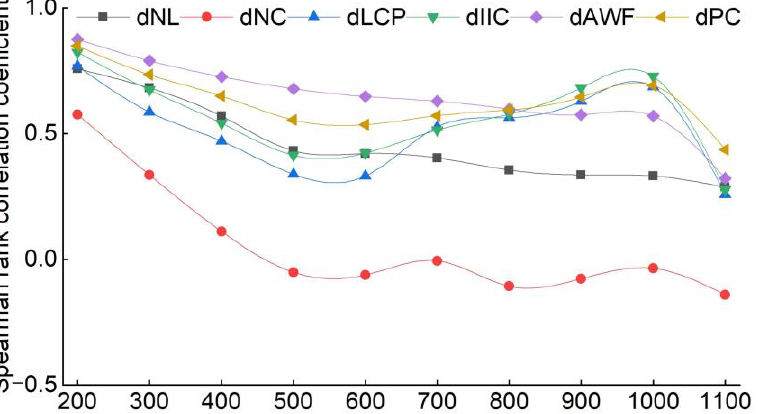
Figure 4. Spearman rank correlations between the dI values under different distance